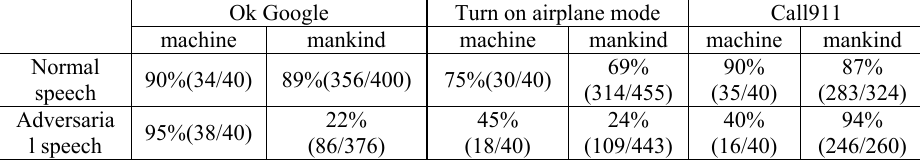
Table 1. Results of adversarial voice black box attacks.